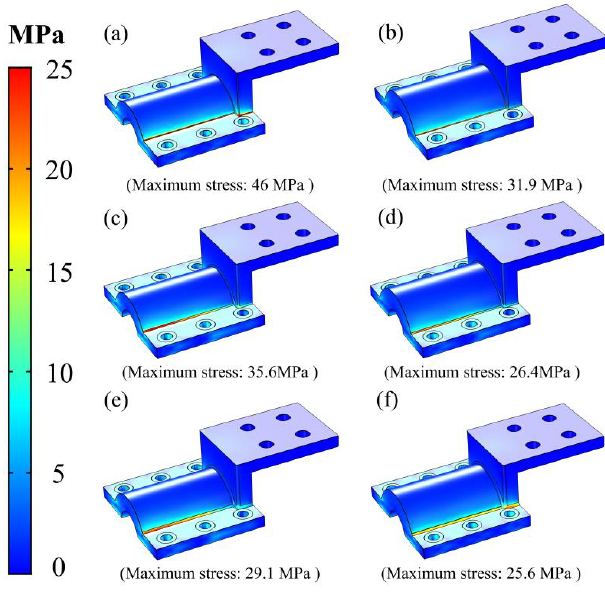
Figure 7. Results of the comprehensive optimization: ( a ) fillet of 1 mm, outer arch thickness of 45 mm; ( b ) fillet of 1 mm, outer arch thickness of 50 mm; ( c ) fillet of 2 mm, outer arch thickness of 45 mm; ( d ) fillet 2 mm, outer arch thickness of 50 mm; ( e ) fillet of 3 mm, outer arch thickness of 45 mm; ( f ) fillet of 3 mm, outer arch thickness of 50 mm. The values in brackets are the respective maximum stress.